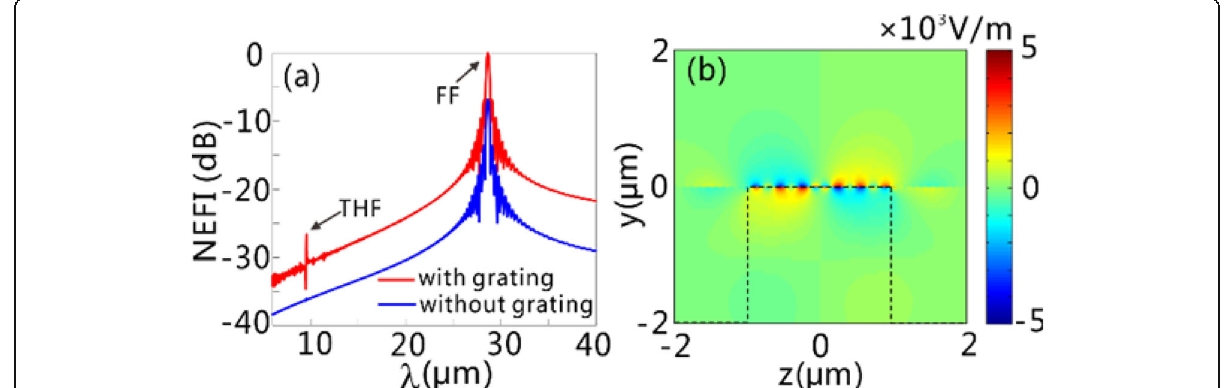
Fig. 4 Generation of THF GPs on the GSSDG. a The NEFI for the structure with (red line) and without (blue line) grating normally illuminated by CW light with the power density of 0.11 MW/cm 2 and the central wavelength of 28.62 μ m. The two peaks in the red line denote the FF GPs ( λ = 28.62 μ m) and the generated THF GPs ( λ = 9.54 μ m), respectively. b The distribution of the real part of E y for the generated THF GPs. The black dashed line in b represents the outlines of the silicon layer. The structural parameters of GSSDG are the same as those in Fig. 3